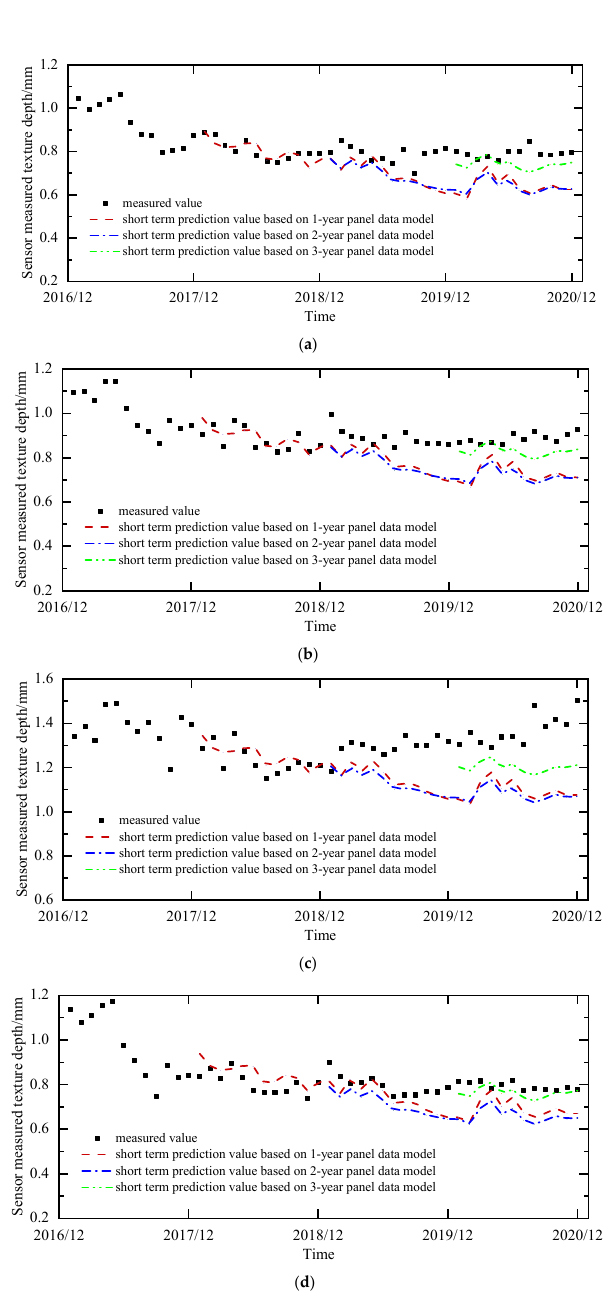
Figure 8. Comparison of measured and predicted SMTD based on different time scales of SMTD panel data. ( a ) SRT-14 (Dense-graded asphalt concrete, SAC13-65%). ( b ) SRT-7 (Dense-graded asphalt concrete, SAC13-70%). ( c ) SRT-9 (Porous asphalt concrete, PAC13-80%). ( d ) SRT-19 (Dense-graded asphalt concrete, SMA13-75%).